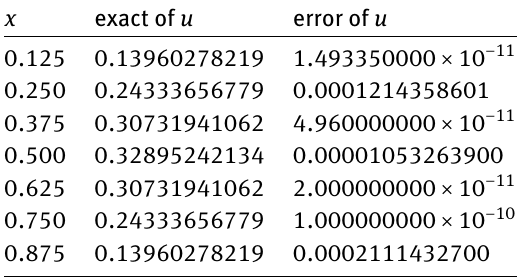
Table 4: The exact value and absolute errors of the this method for Example